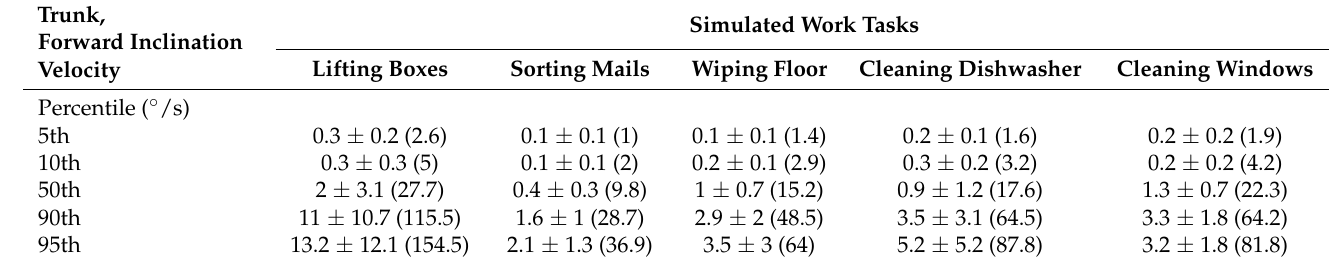
Table 4. The mean ± standard deviation of the mean absolute errors (MAEs) of the trunk inclination velocity between cloth sensors and skin sensors during the five simulated tasks, with the reference value of skin sensors shown in brackets ( n =